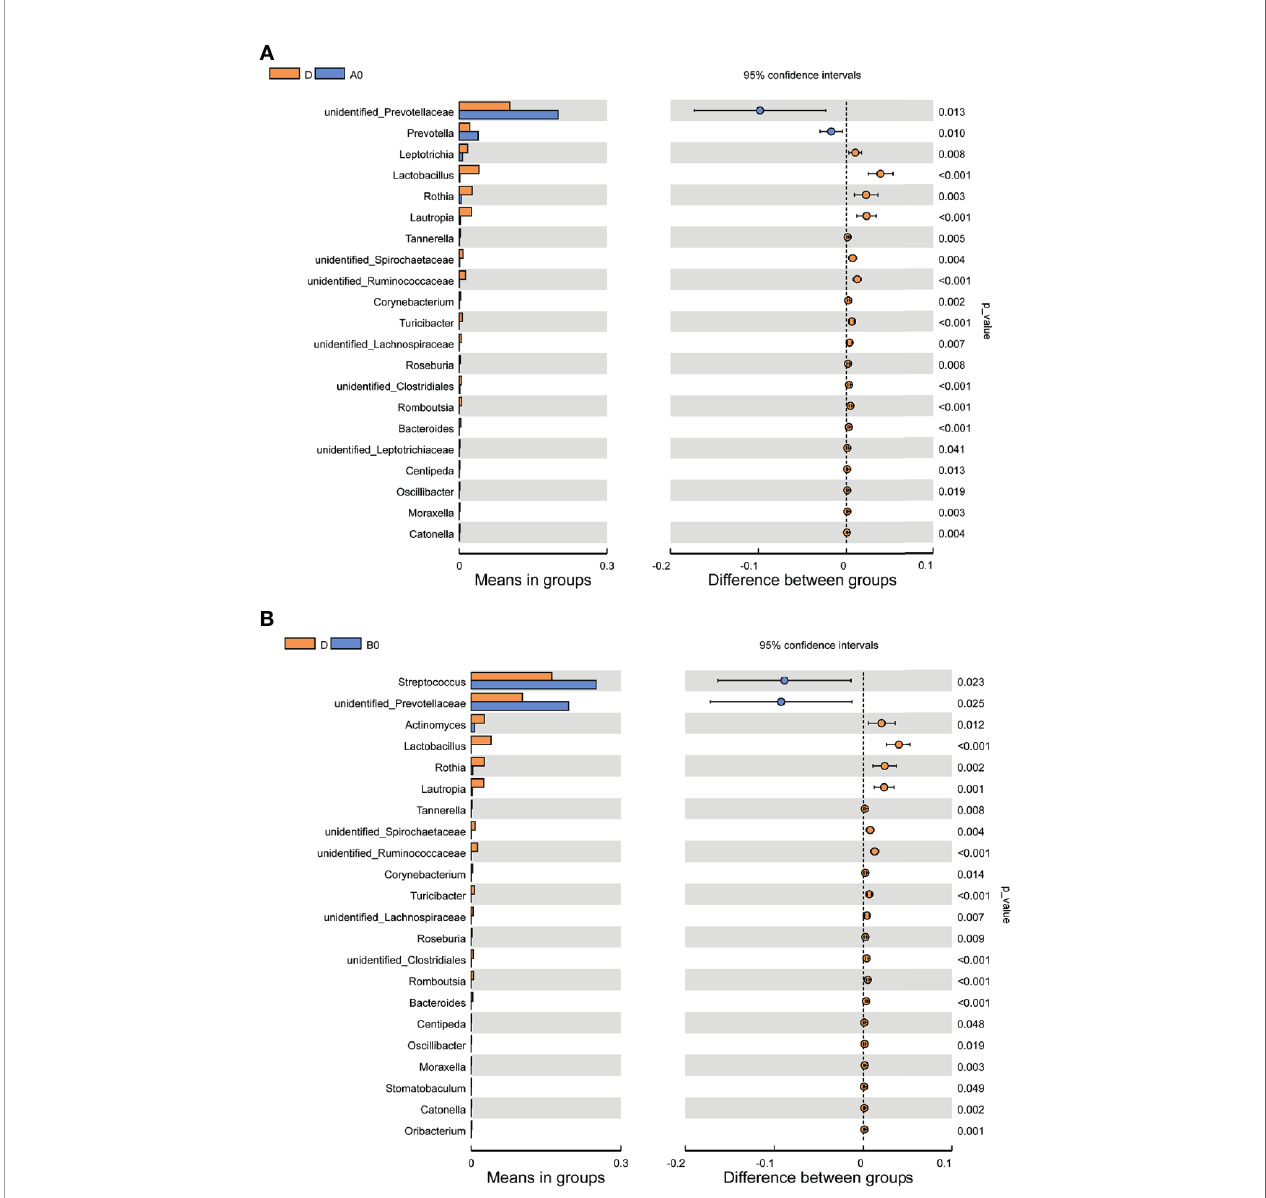
FIGURE 2 | Comparisons of the relative abundance in oral microbiota at the genus level (A) Between A0 and D groups; (B) Between B0 and D groups. A0, people living with acute HIV infection at baseline; B0, people living with chronic HIV infection at baseline; D, HIV-uninfected controls; A12, people living with acute HIV infection after 12 weeks of ART; B12, people living with chronic HIV infection after 12 weeks of